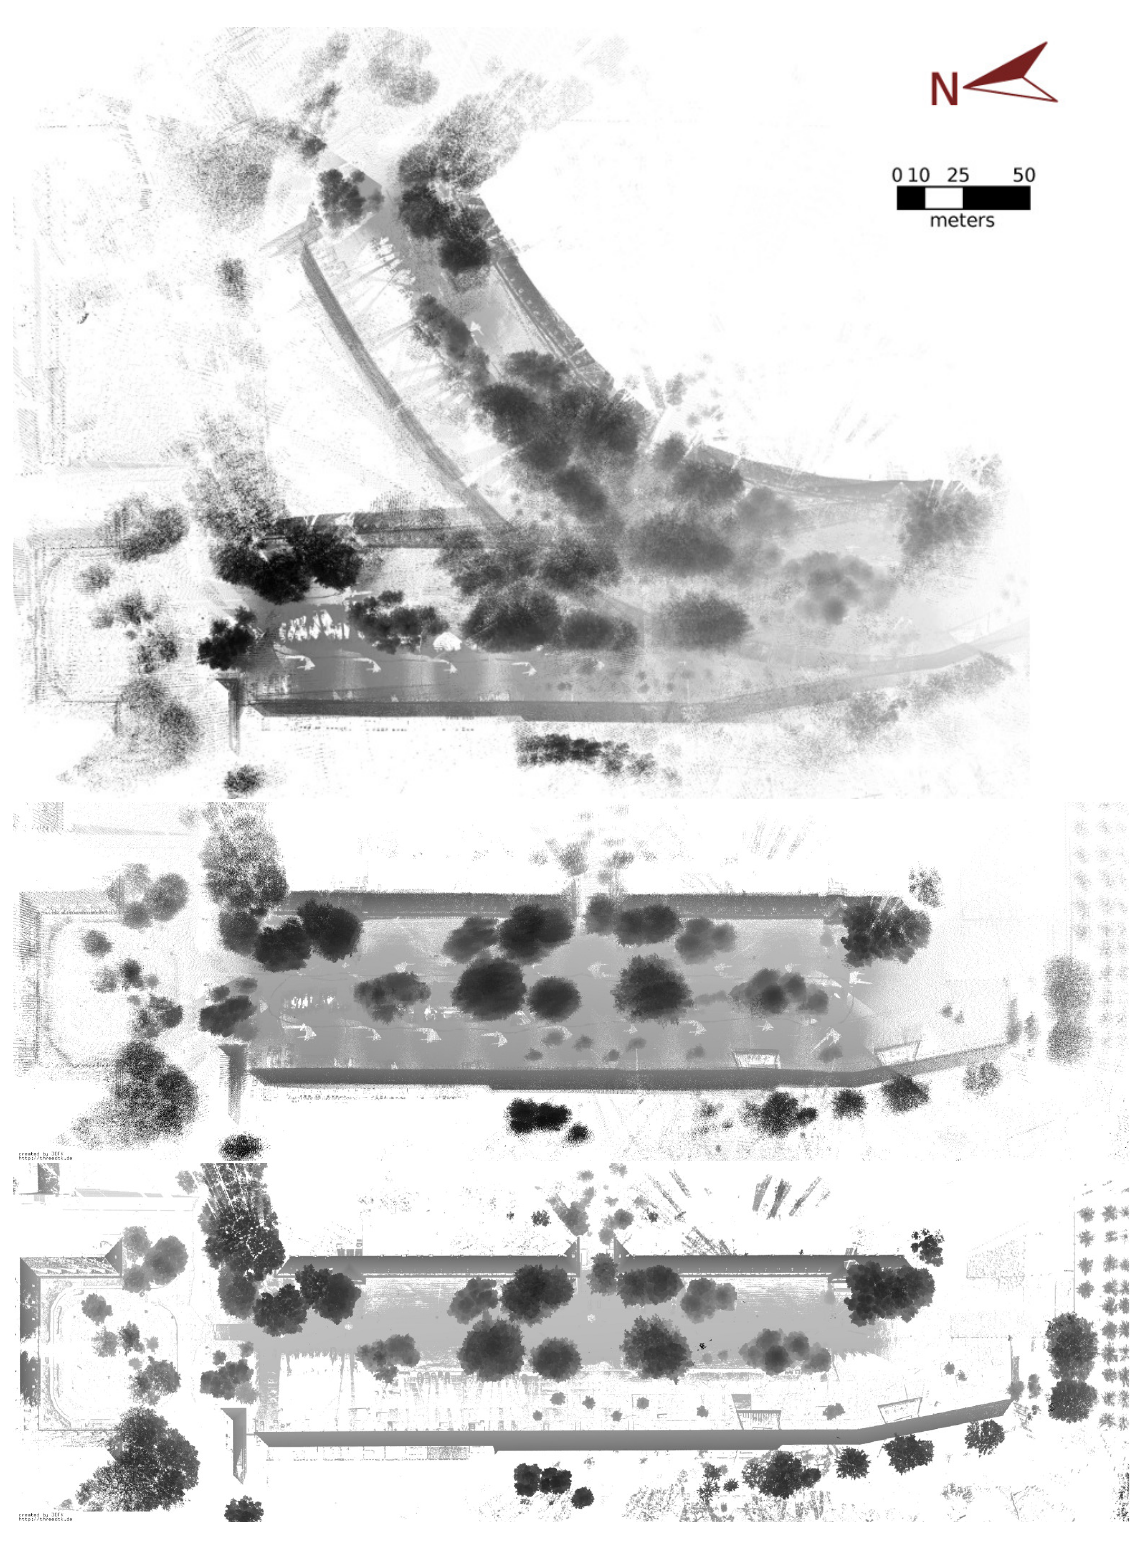
Figure 12. A comparison of the initial and optimized Campus point cloud acquired by the mobile laser scanner with the ground truth data acquired by a terrestrial laser scanner. ( Top ) The initial point cloud of the car dataset with about 12 million points. ( Middle ) The result of the novel semi rigid registration algorithm. ( Bottom ) The ground truth dataset acquired with the Riegl VZ-400 mounted on a tripod at twelve